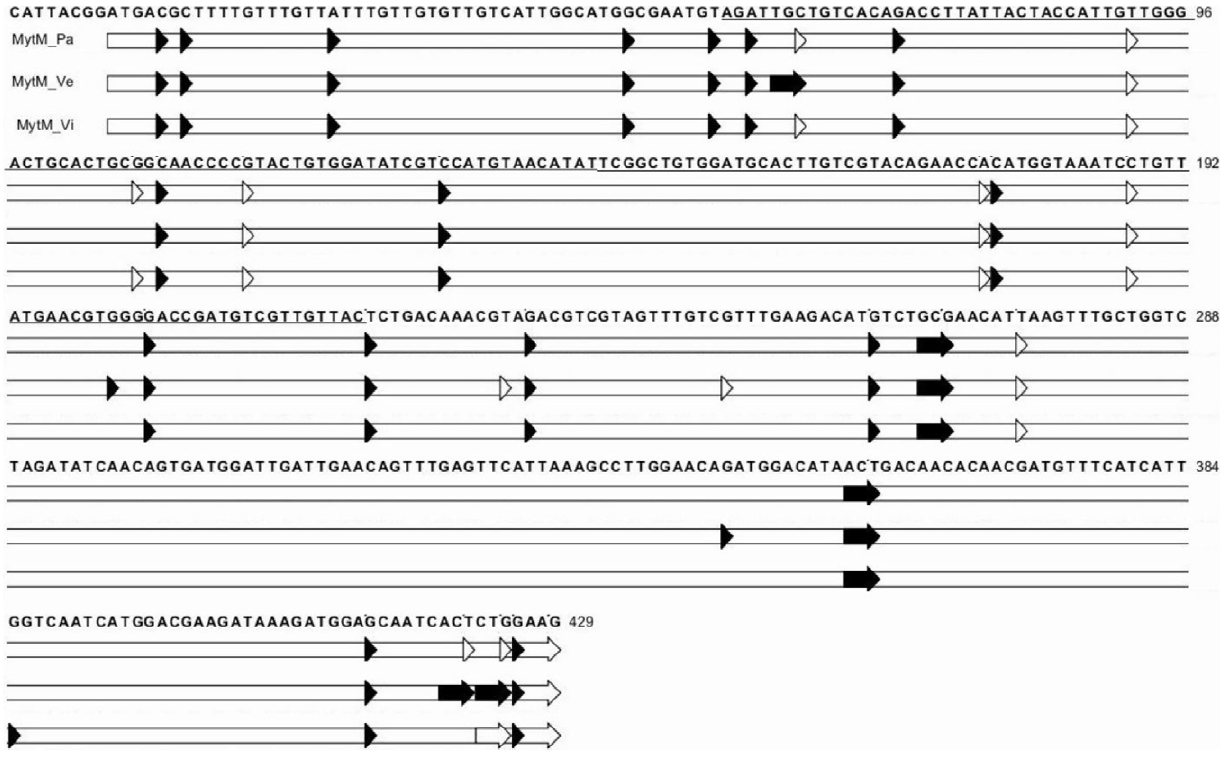
Figure 4. SNCs mapped along the MytM sequence in the Pa, Ve and Vi samples. Synonymous (empty) and non-synonymous (filled) changes are located on the AMP precursor sequence. Empty horizontal bars indicates cds, mature peptide sequence is underlined.